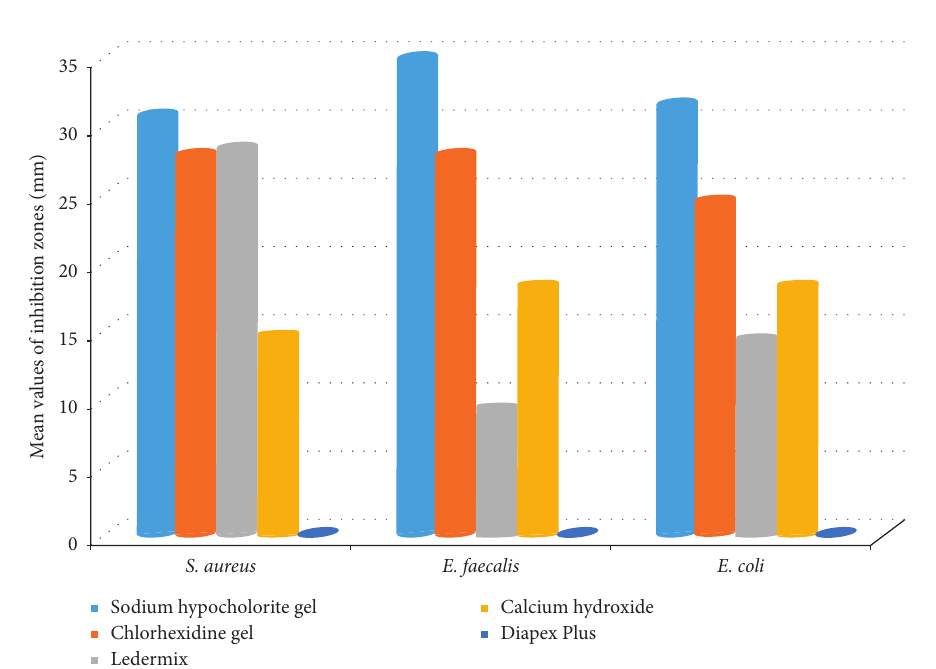
∗ Games–Howell post hoc test: different uppercase letters (columns) and different uppercase numbers (rows) indicate statistically significant differences ( P < 0 . 05) among the tested medicaments against the same microorganism and among antimicrobial effects of each medicament against tested micro- organisms,